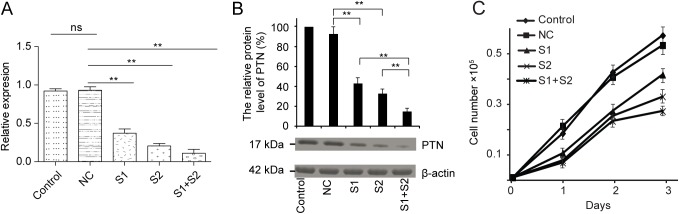
The silence efficiency of PTN siRNA measured by quantitative RT-PCR and western blotting.The PTN expression level showed a direct correlation with the proliferation rate of B16-F10 melanoma cells. (A). Quantitative RT-PCR analysis of the knock-down efficiency of siRNA 1, siRNA 2 and the mixture of them at the same dose. GAPDH was used as a control. (B). Western blotting analysis of the knock-down effect of siRNA 1, siRNA 2 and the mixture of them at the same dose. β-actin was used as a control. The intensity of the control sample without transfection of any siRNA was set as 100%. Asterisks indicate statistically significant differences between samples (** p<0.01 and ns for no significant difference). (C). Silence of the PTN by siRNA reduced the proliferation rate of B16-F10 melanoma cells in a manner directly related the reduced level of PTN. Each point represents the mean ± standard deviation of 3 replicates.